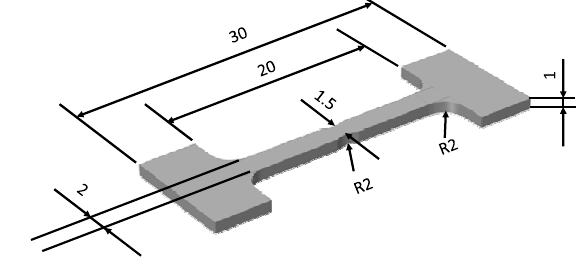
Figure 3: Notched specimen.